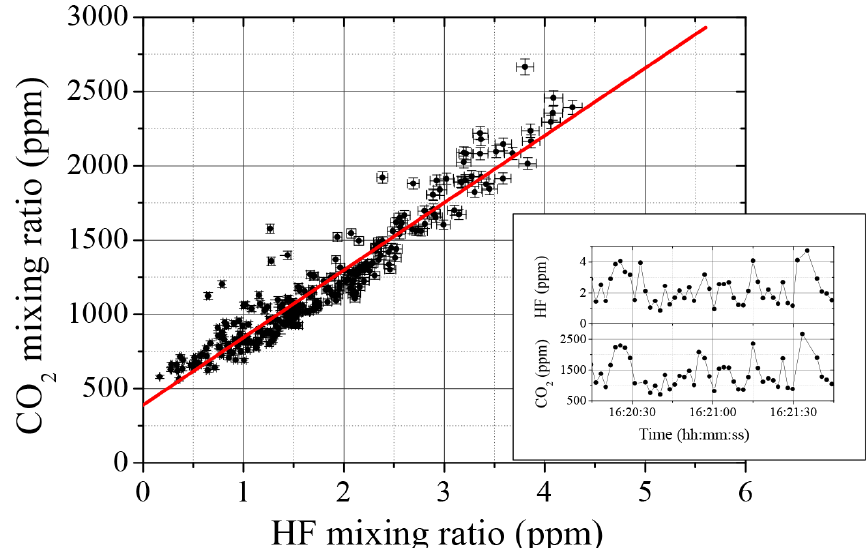
Figure 9. CO 2 mixing ratio as a function of the HF mixing ratio for 13min of measurement in proximity to a fumarole of the Vulcano volcano on 20 May 2015. The red line is the result of a linear fit. The error bars are the accuracy of the mixing ratio values. The measurement was carried out in the open-cell configuration at a pressure of 990mbar and at a temperature variable between 310 and 320K. The inset shows a close-up of the time series of CO 2 and HF mixing ratios during a 90s